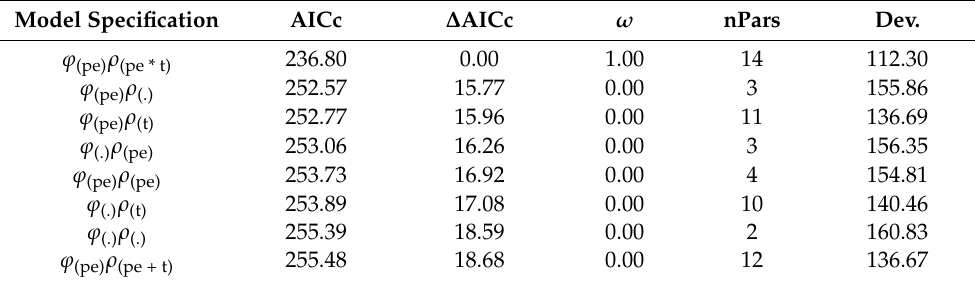
Table 4. Summary of hatchling survival models, including resighting probability ( ρ ) and survival probability ( ϕ ) and taking into account interannual variability between the 2017/2018 and the 2018/19 periods. Model selection was based on Akaike’s information criterion corrected for small sampling size (AICc); ∆ AICc is the difference between the current model and the one with the lowest AICc value. Model weights ( ω ), number of parameters (nPars) and relative deviance (Dev.) are also shown. See ESM Table S6 for statistical